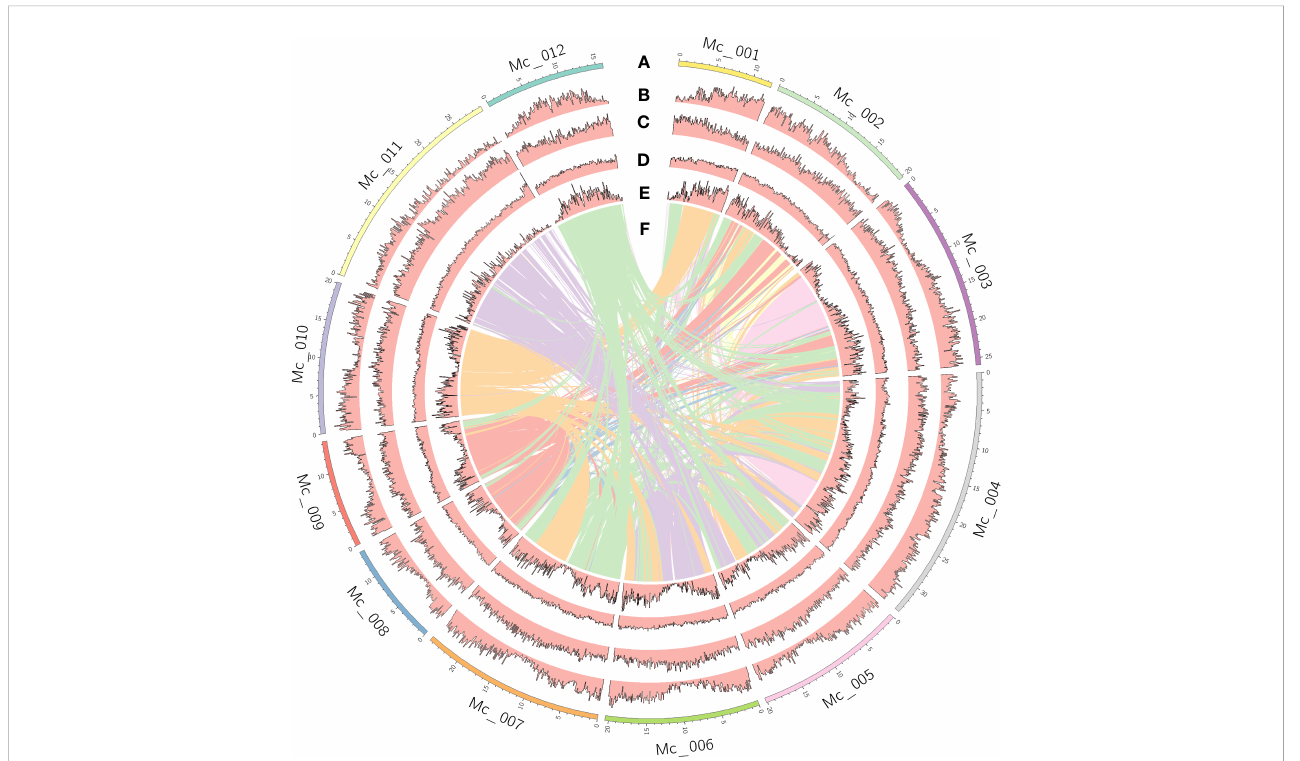
FIGURE 2 Genome features of Melastoma candidum . Tracks displayed are: (A) 12 pseudochromosomes; (B) gene density; (C) density of repeats; (D) GC content; (E) density of genes in the syntenic blocks; (F) inter-chromosome